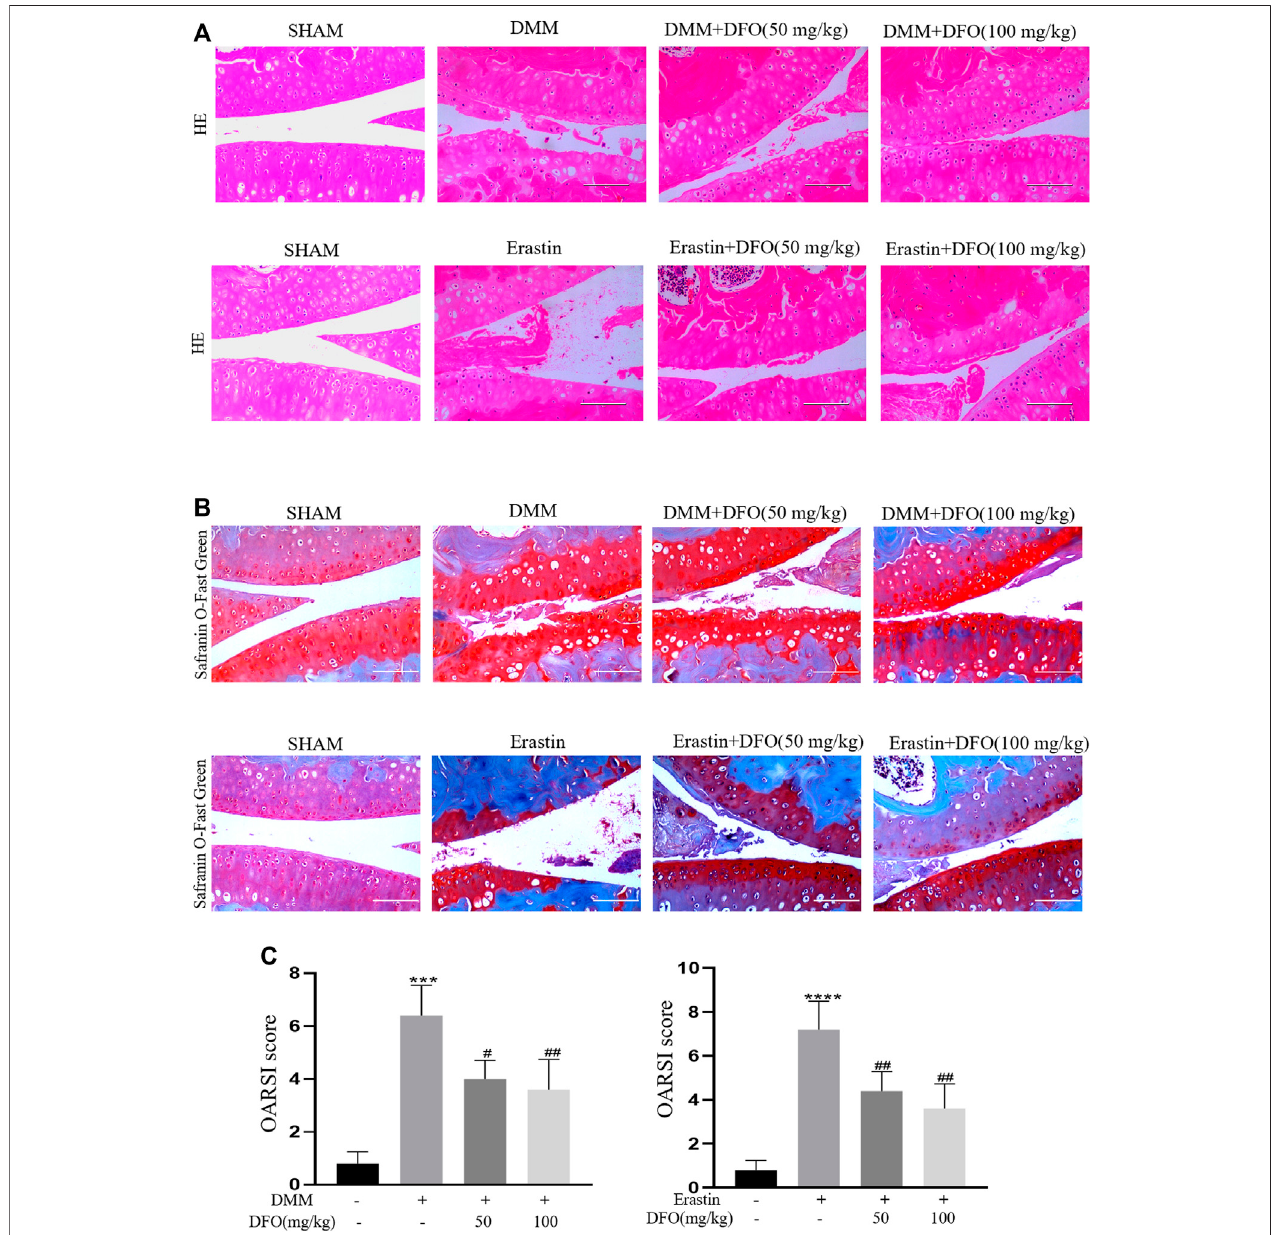
FIGURE7| EffectofDFOonthecartilagedegradation invivo .Micereceivedintra-articularinjectionofDFO(50or100 mg/kg)orerastin(5 mg/kg) orvehicle(saline) for 8 weeks after DMM surgery. (A,B) Cartilage degradation was histologically evaluated by hematoxylin-eosin staining and safranin O staining/fast green (Scale bar: 100 μ m). (C,D) The progression of OA was evaluated using the OARSI scores. *** p < 0.0001 versus the sham group, **** p < 0.0001 versus the sham group, # p < 0.05 versus the DMM group, and ## p < 0.01 versus the DMM group, n = 8.